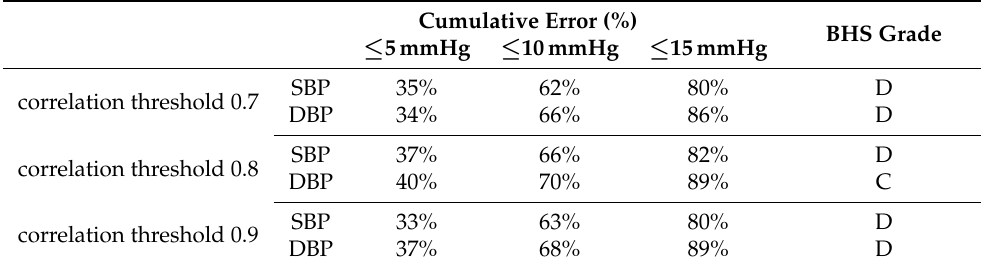
Table 8. Comparison of our small network performances with BHS standard.